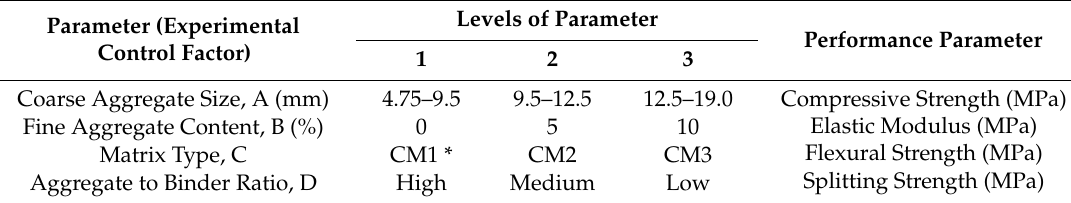
Table 3. Parameters and design levels for pervious concrete.